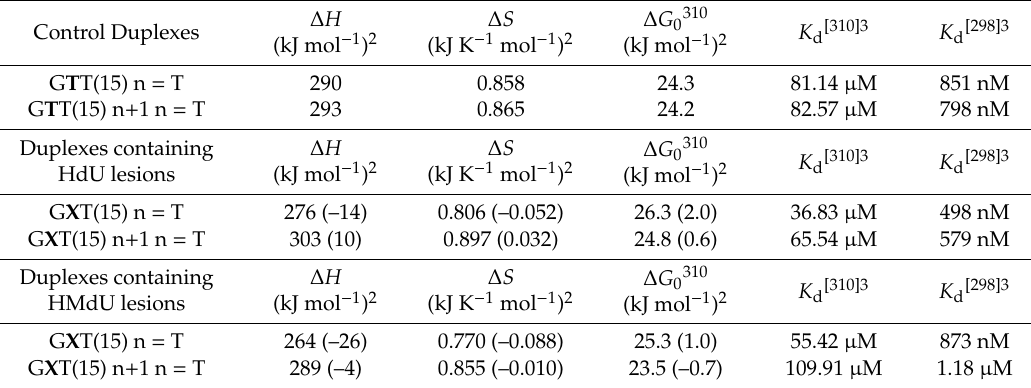
Table 4. MST-derived thermodynamic parameters of dissociation of duplexes formed between the 15mer DNA templates G T T(15) and G X T(15) (X = HdU or HMdU) and the matched or mismatched primers n or n + 1, where n = T nucleotide.